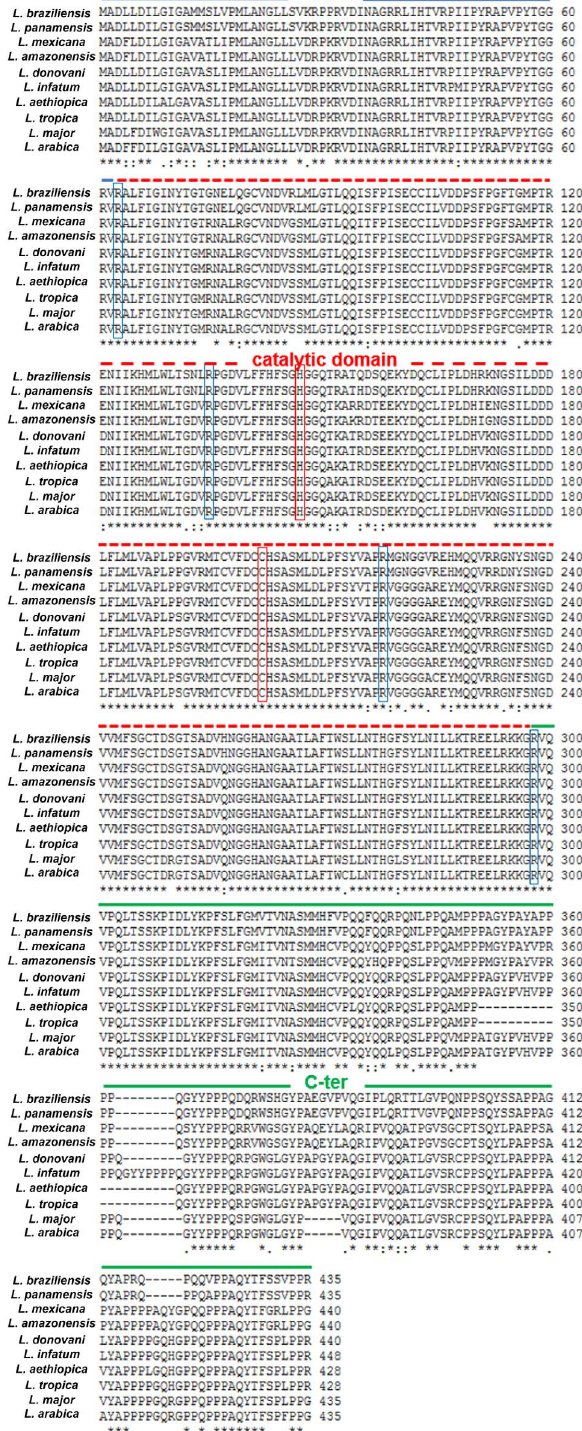
Figure 3. Alignment of the amino-acid sequences of the MCA orthologs in different Leishmania species. The N-terminal domain, which contains a mitochondrial localization signal, from amino-acids 1 to 62, is indicated in blue; the catalytic domain, containing the catalytic dyad histidine 147/cysteine 202 (boxed in red), is indicated by a dashed red line; the proline-rich C-terminal domain is indicated by a green line. Demonstrated cleavage sites are boxed in blue: R63, R136, R218 and